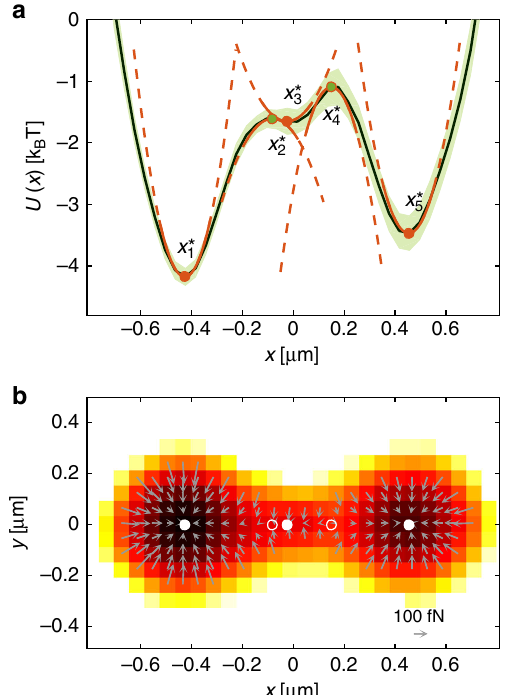
Fig. 4 Reconstruction of stable and unstable equilibrium points. a Multiwell optical potential generated by two focused Gaussian beams slightly displaced along the x -direction. FORMA identi fi es three stable ( x (cid:3) , x (cid:3) , x (cid:3) ; 1 3 5 full circles) and two unstable ( x (cid:3) , x (cid:3) ; empty circles) equilibrium points, and 2 4 measures their stiffness (orange solid and dashed lines). The corresponding x -potential obtained from the potential method is shown by the green solid line (the green shaded area represents one standard deviation obtained repeating the experiment 20 times). b 2D plot of the force fi eld measured with FORMA (arrows) and of the potential measured with the potential analysis (background colour). The stable and unstable equilibrium points are indicated by the full and empty circles, respectively. We have acquired trajectories of the motion of a spherical particle with radius R = 0.48 μ m in an aqueous medium of viscosity η = 0.0011 Pa s − 1 at a sampling frequency f = 4504.5 s − 1 , and used 20 windows of 4.5 × 10 5 samples for the s